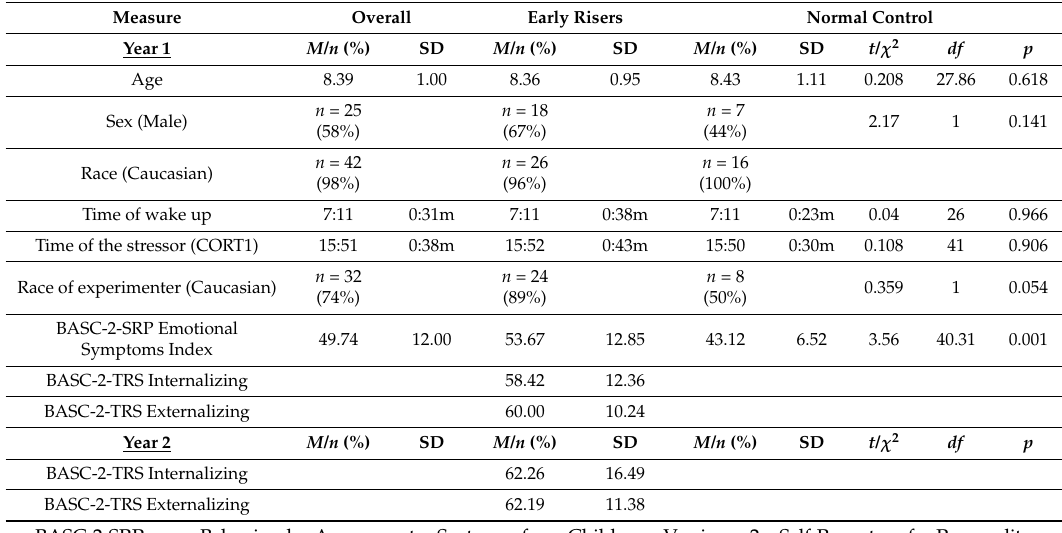
Table 1. Demographic and psychopathology data for participants by group status.